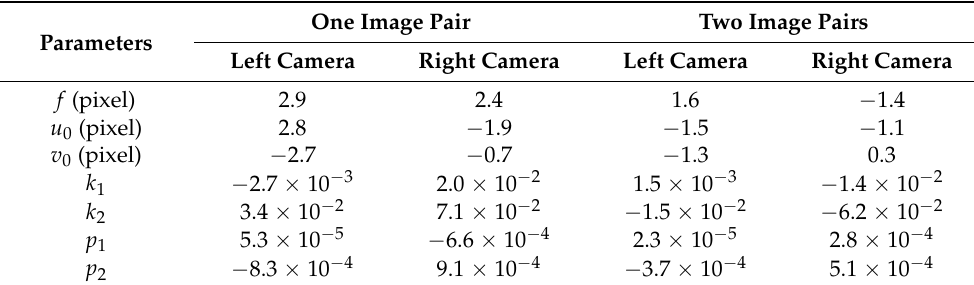
Table 2. RMSE of calibration results.